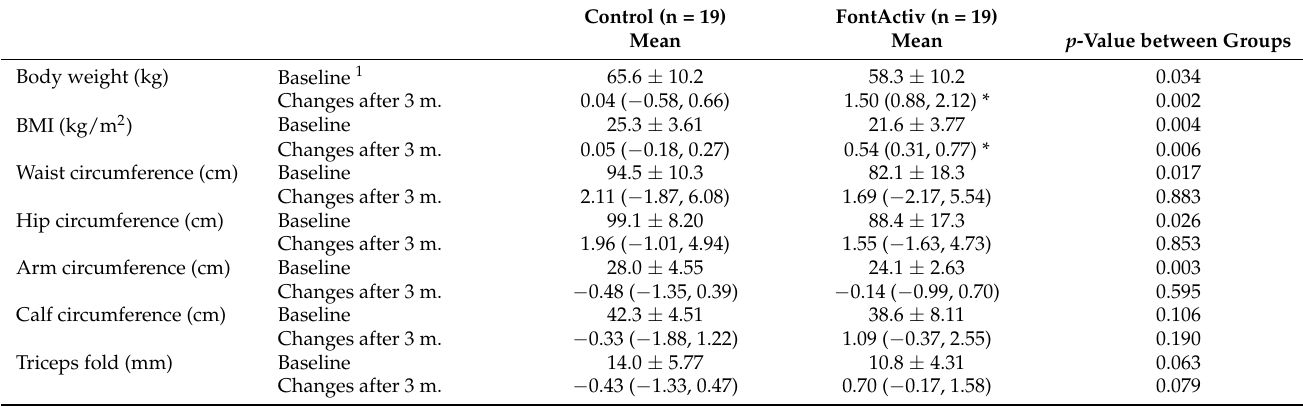
Table 3. Anthropometric changes in CKD participants according to the intervention arm after 3 months of intervention.